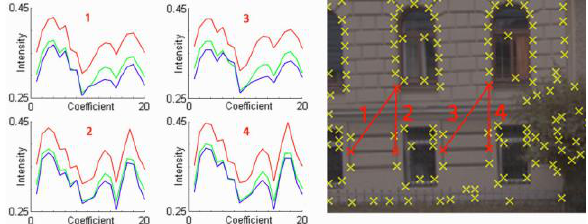
Figure 7: Detected Harris corners and the extracted intensity profiles consisting of 20 values for every RGB channel (taken from Wendel et al. 2010)